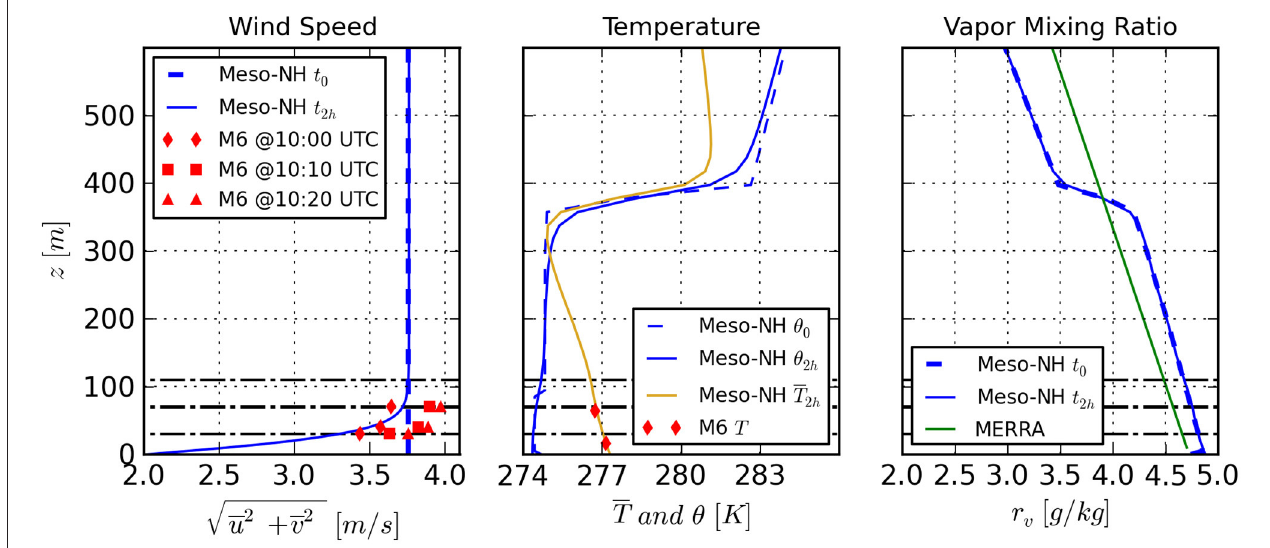
FIGURE 6 | Wind speed, temperature and vapor mixing ration profiles. M6 Data from Hasager et al.